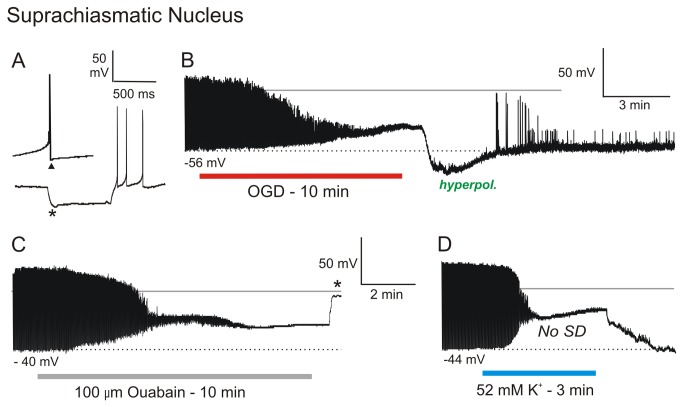
SCN neurons also resist depolarization during OGD, ouabain and 52 mM [K+]o exposure and subsequently recover.A) In response to a hyperpolarizing current pulse an SCN neuron shows pronounced inward rectification (arrow) and a biphasic afterhyperpolarizing potential (arrowhead). B) SCN neuron responds to 10 minutes of OGD by slowly depolarizing before reaching a plateau as action potentials inactivate. After return to control aCSF it rapidly repolarizes, followed by a hyperpolarizing undershoot. C) SCN neuron responds to10 minutes 100 µM ouabain similar to OGD but the recording is lost (asterisk) before recovery. D) SCN neuron in responds to 3 minutes of 52 mM [K+]o. It depolarizes to a plateau as action potentials inactivate, but does not generate SD. Back in control aCSF, the neuron returns to the original resting potential.